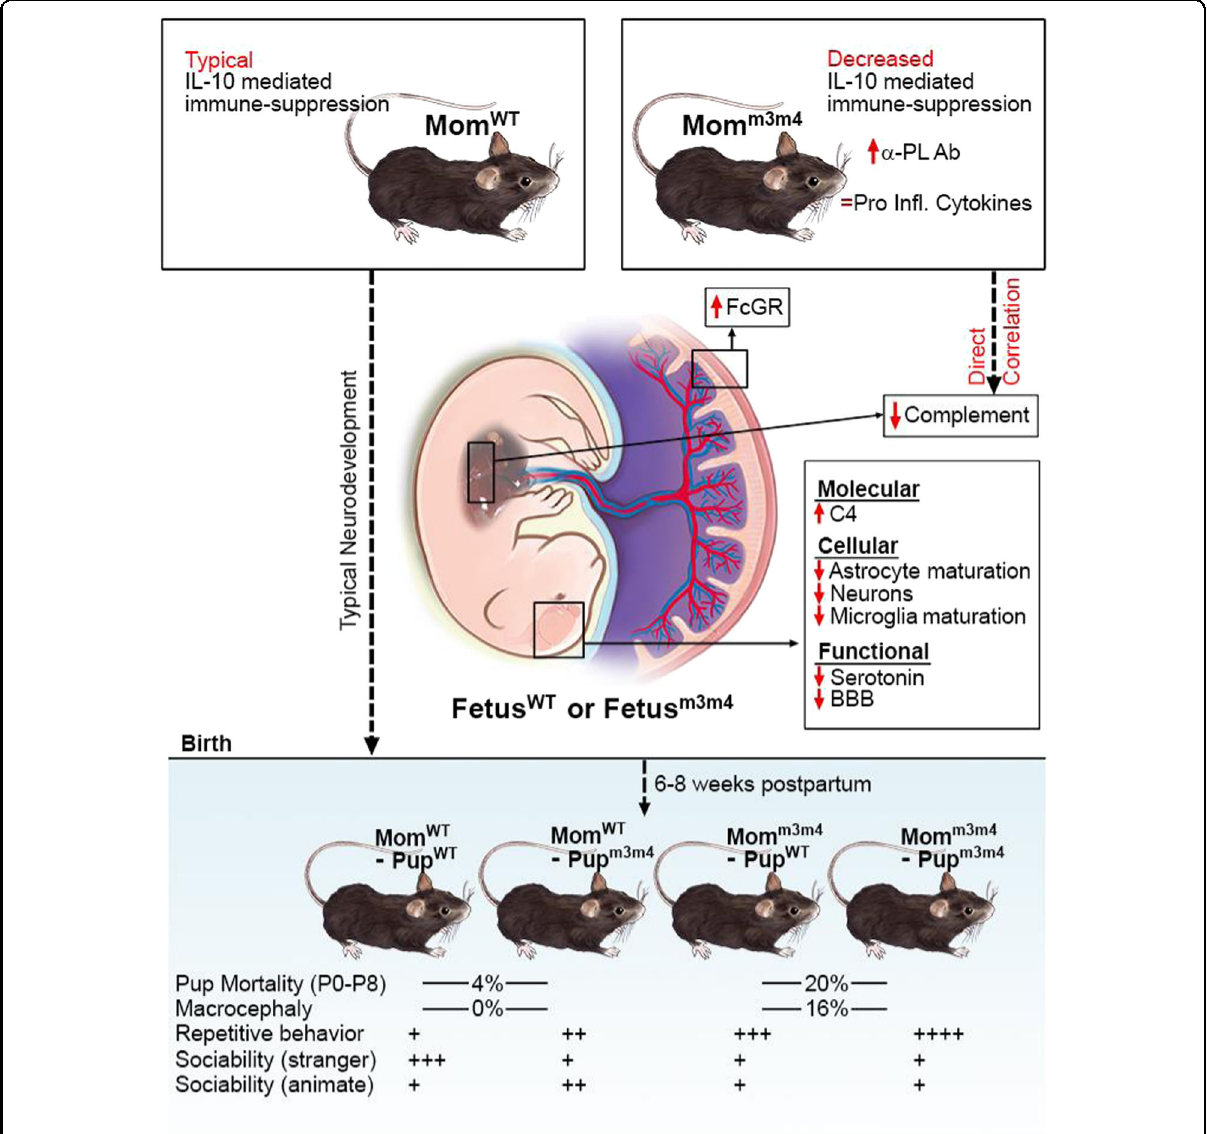
Fig. 5 Schematic summarizing the effect of maternal genetics on fetal neurodevelopmental processes. The impact of maternal genotype on in-utero gene transcription in the offspring is evident in fetal neuropathology and postnatal ASD-like